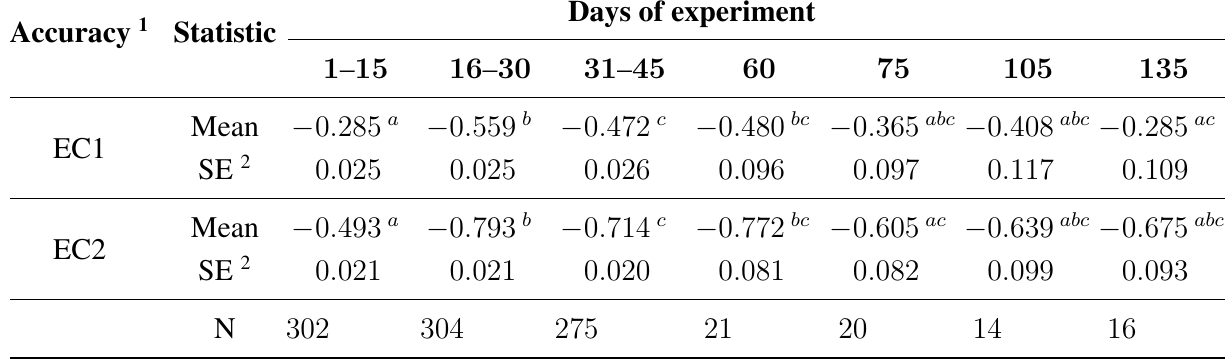
Table 9. Results of ANOVA analysis of C3 conductimeter accuracy (mS/cm) among time of on-line milking parlour